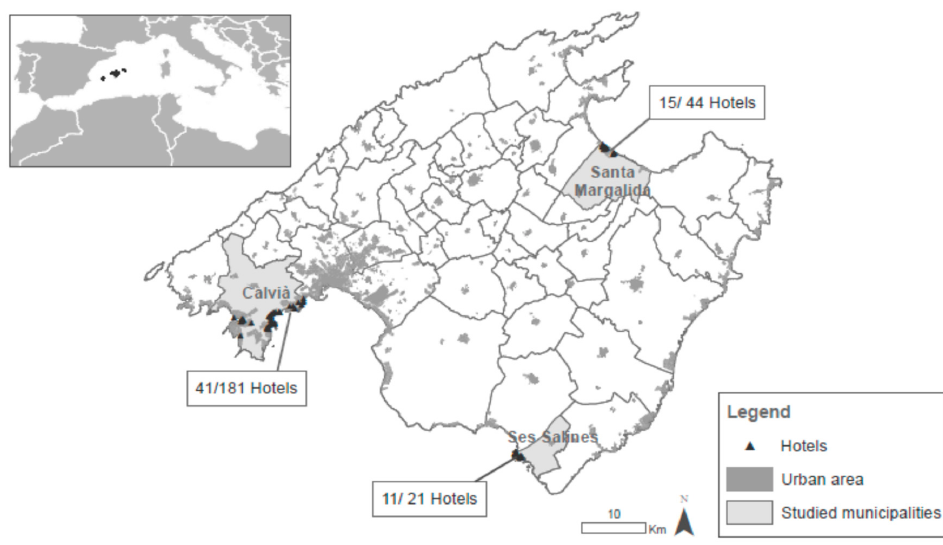
Figure 1. Location of the three municipalities on the island of Mallorca.